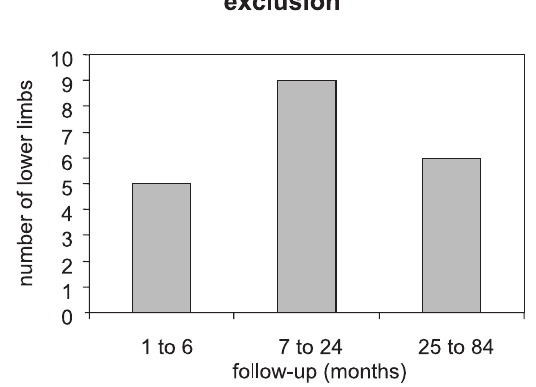
Figure 1 - Late ultrasonographic control of excluded popliteal artery aneurysms